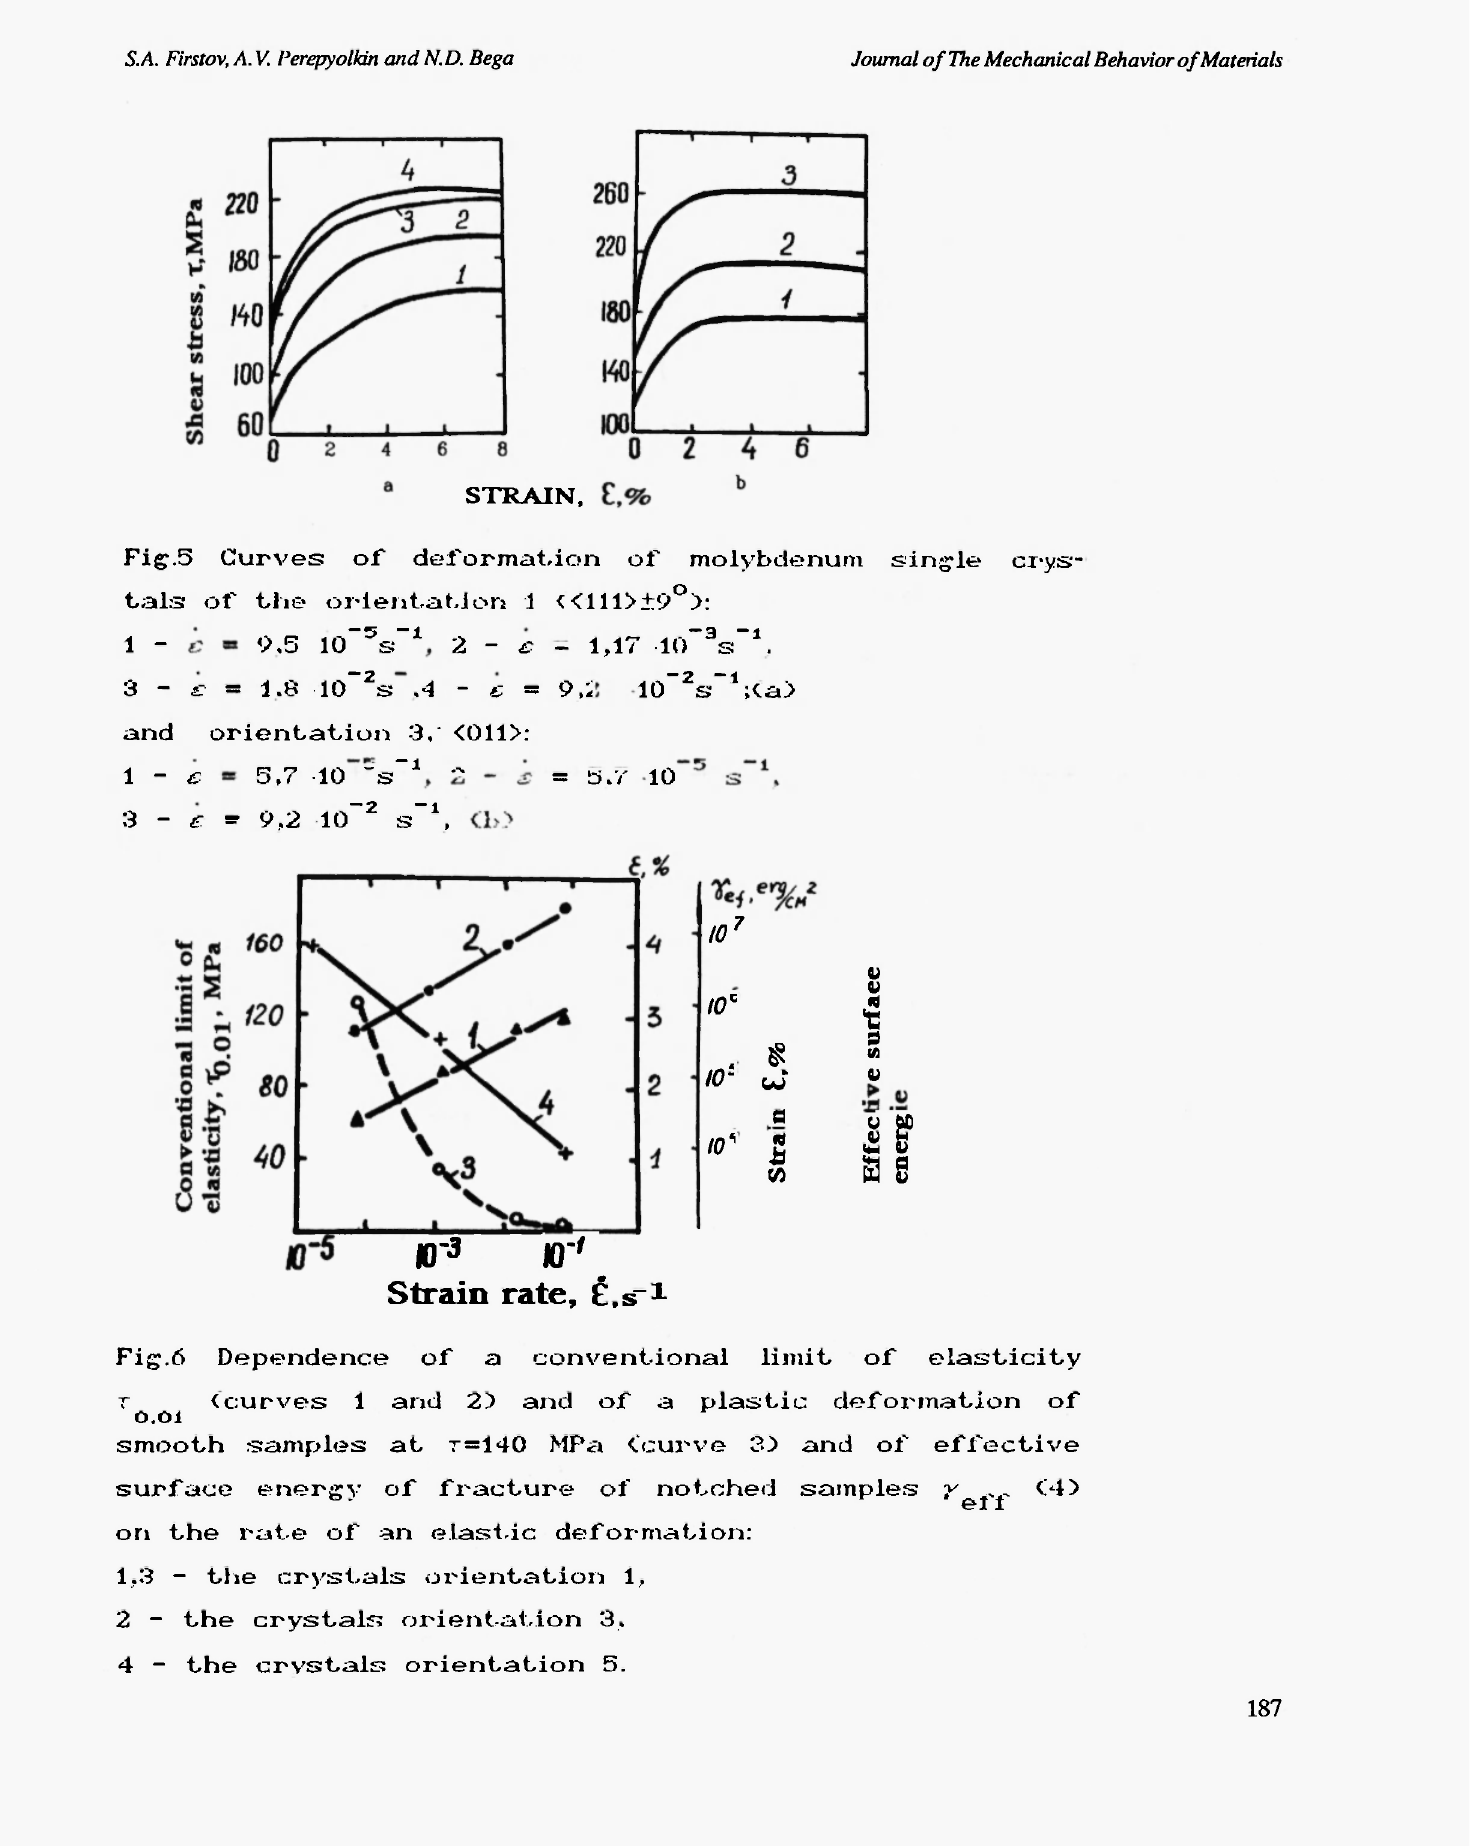
STRAIN, Fig .5 Curves of deformation of molybdenum single crys- t a ls of